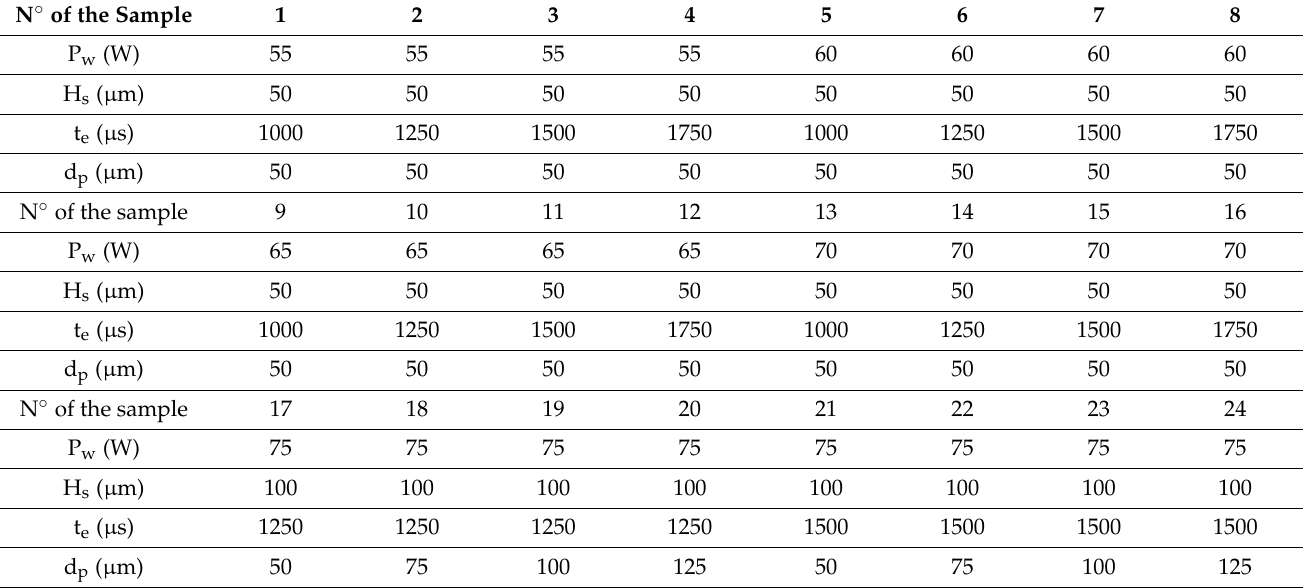
Table 1. Description of the samples according to the process parameters: Laser Power (P w ), Hatch Space (H s ), laser exposition time (t e ), and distance between two pulses (d p ).